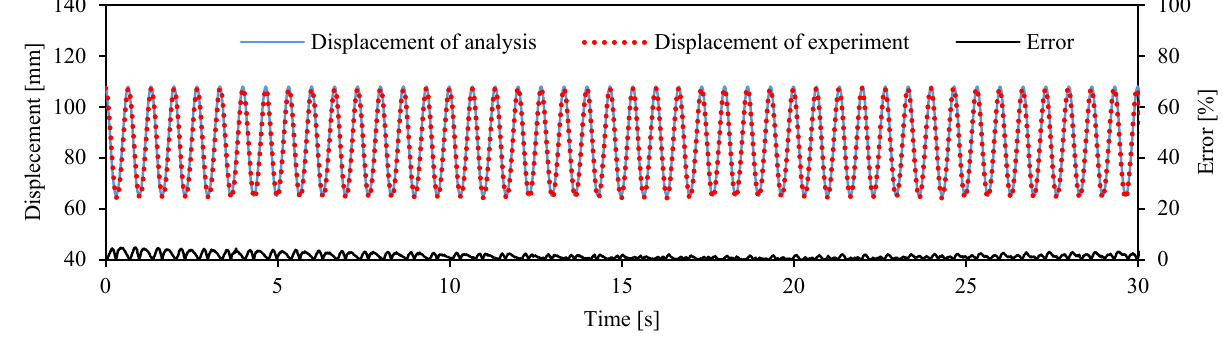
Figure 8. Graphs of displacement based numerical analysis vs. time for confirming damping coeffi- cient.